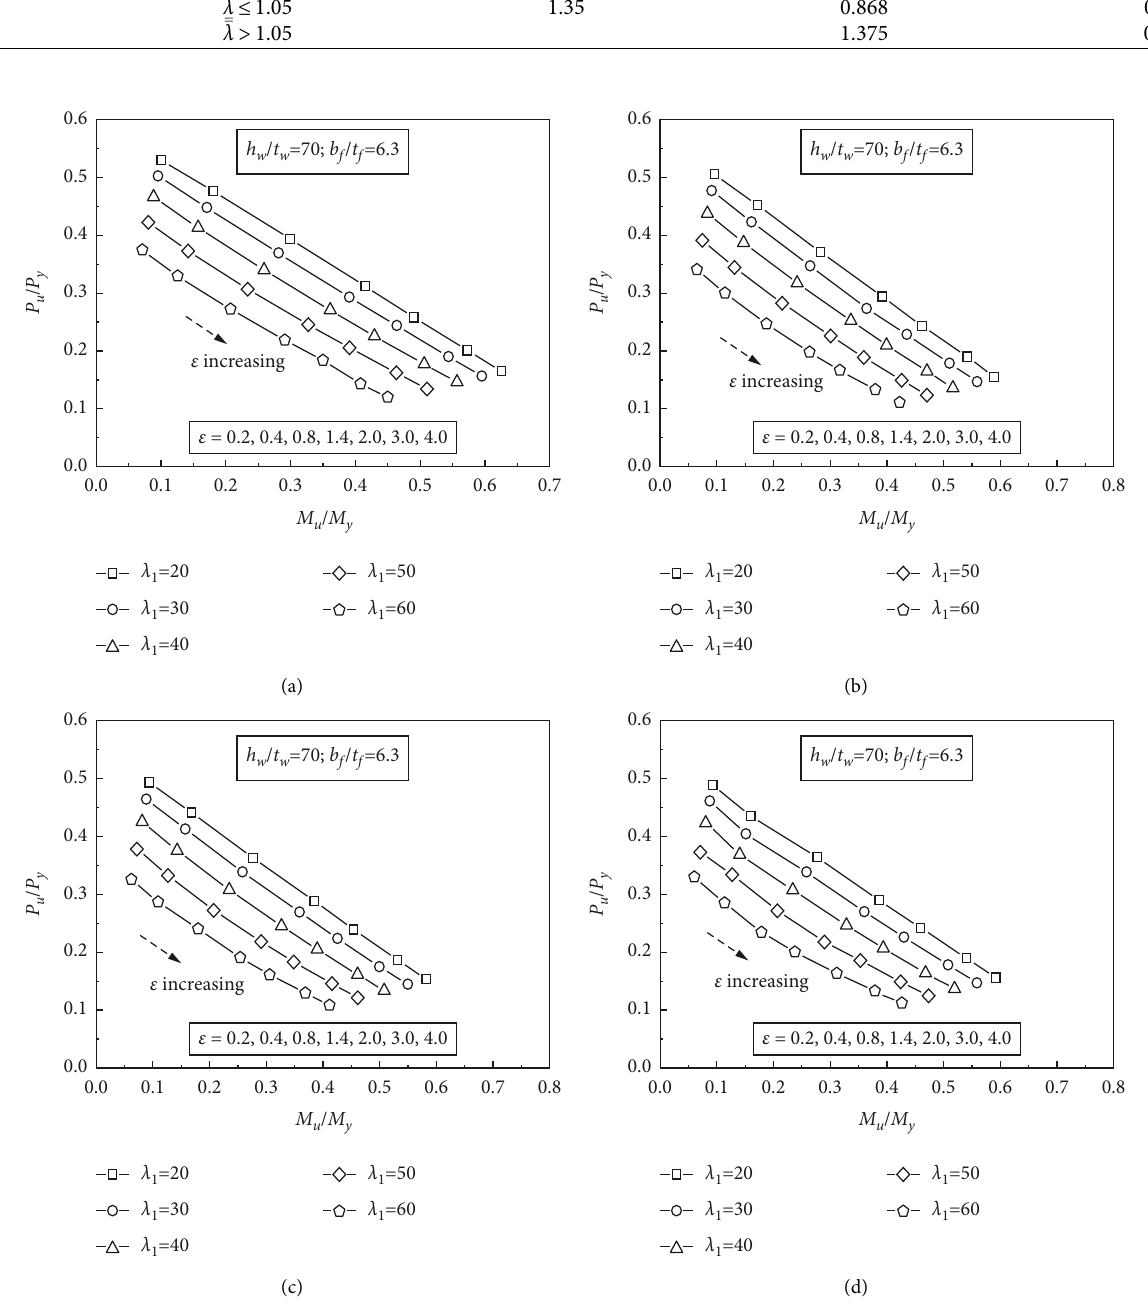
Figure 11: Relative curves of P u / P y versus M u/ M y : (a) Q460; (b) Q690; (c) Q800; and (d) Q960.